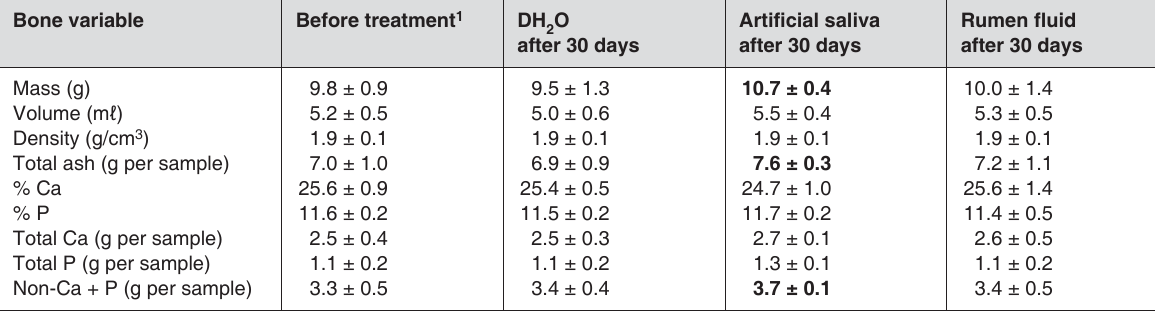
O), artificial saliva, and rumen fluid on metacarpus shaft bone samples 2